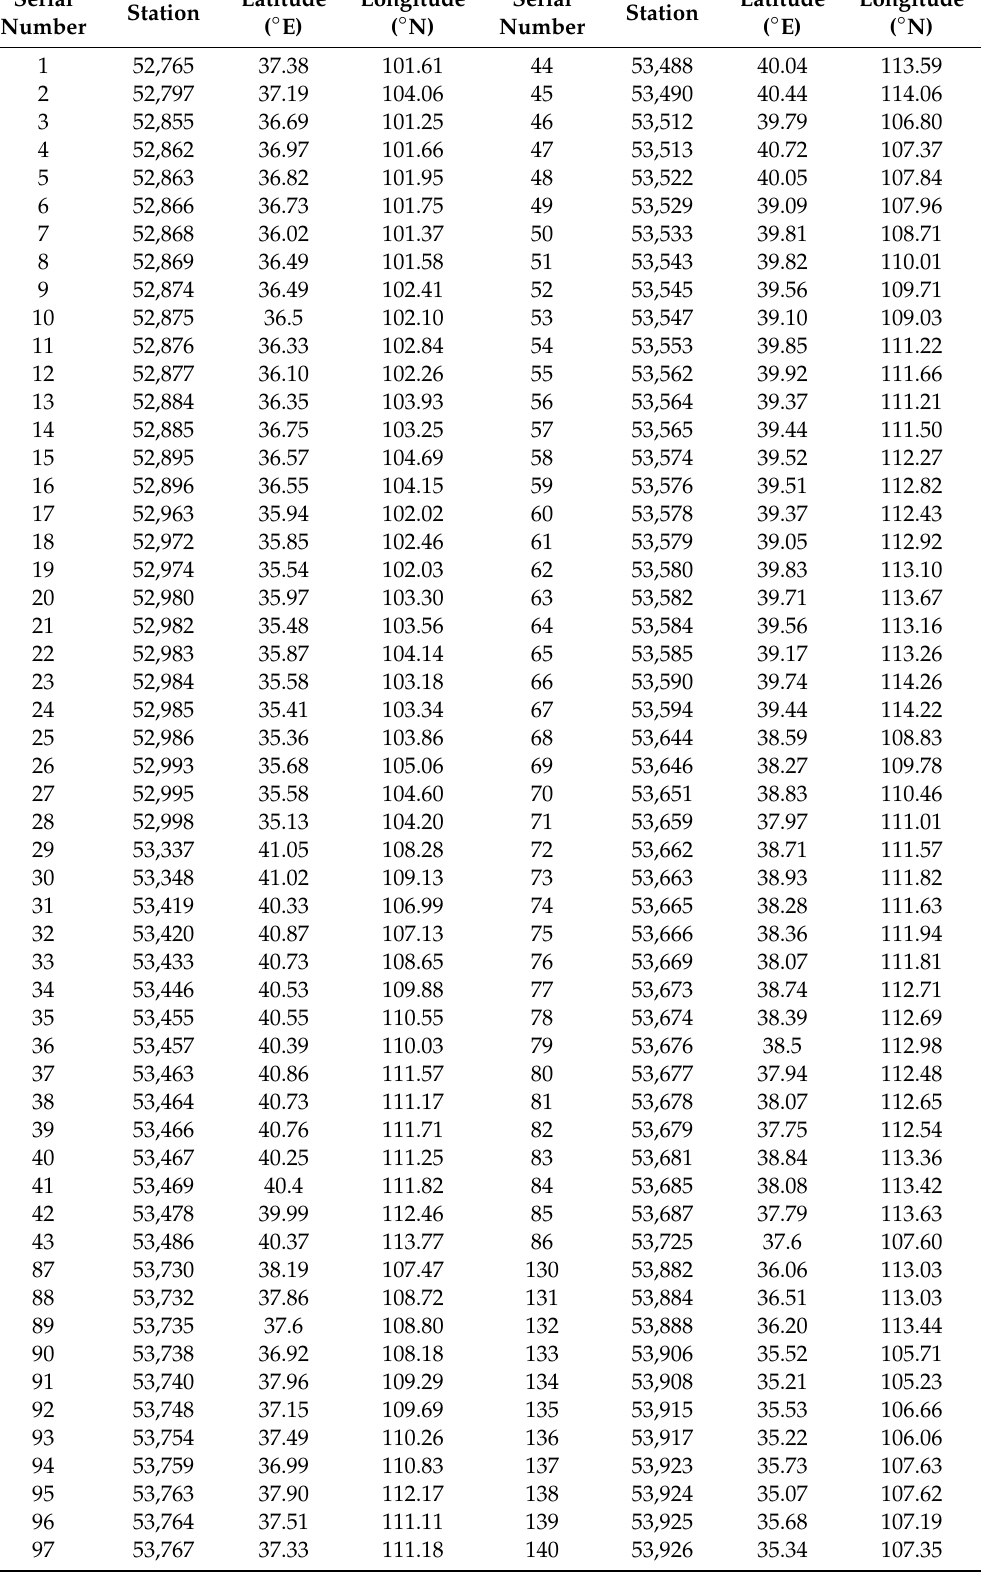
Table A1. Locations of the automatic RSM observation stations within the Chinese Loess